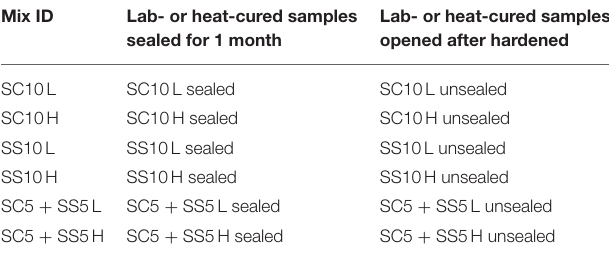
TABLE 3 | Curing details symbols of lab- and heat-cured samples of shrinkage measurement. Mix ID